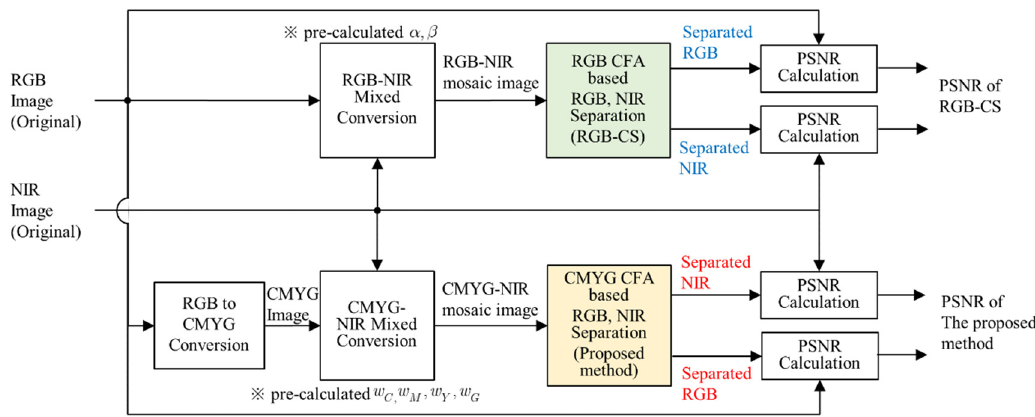
Figure 9. Block diagram of simulation method for the measurement of objective quality.